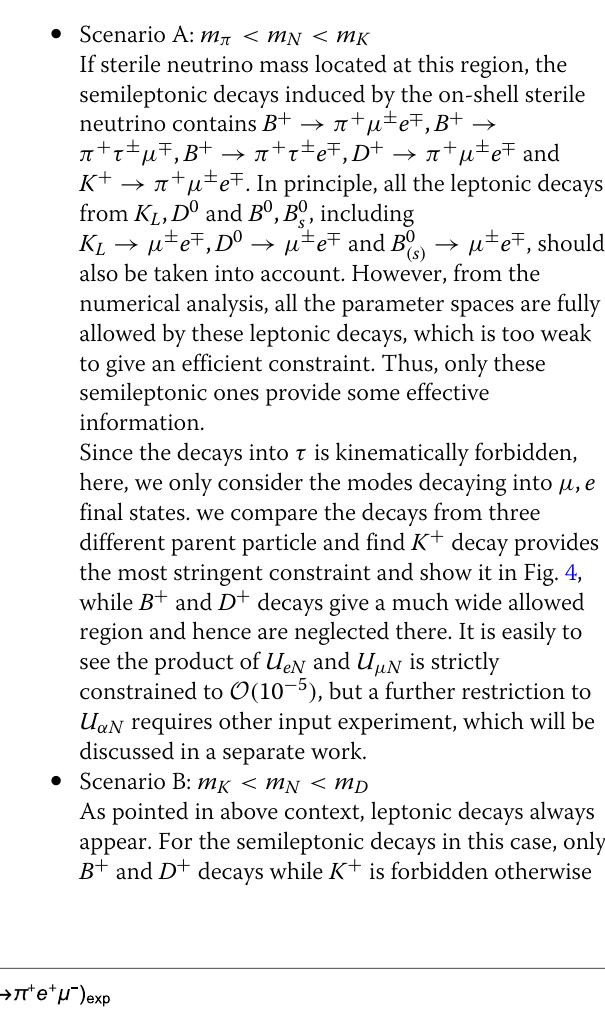
Fig. 3 The behavior of function A , in which the black dot stands for SM situation